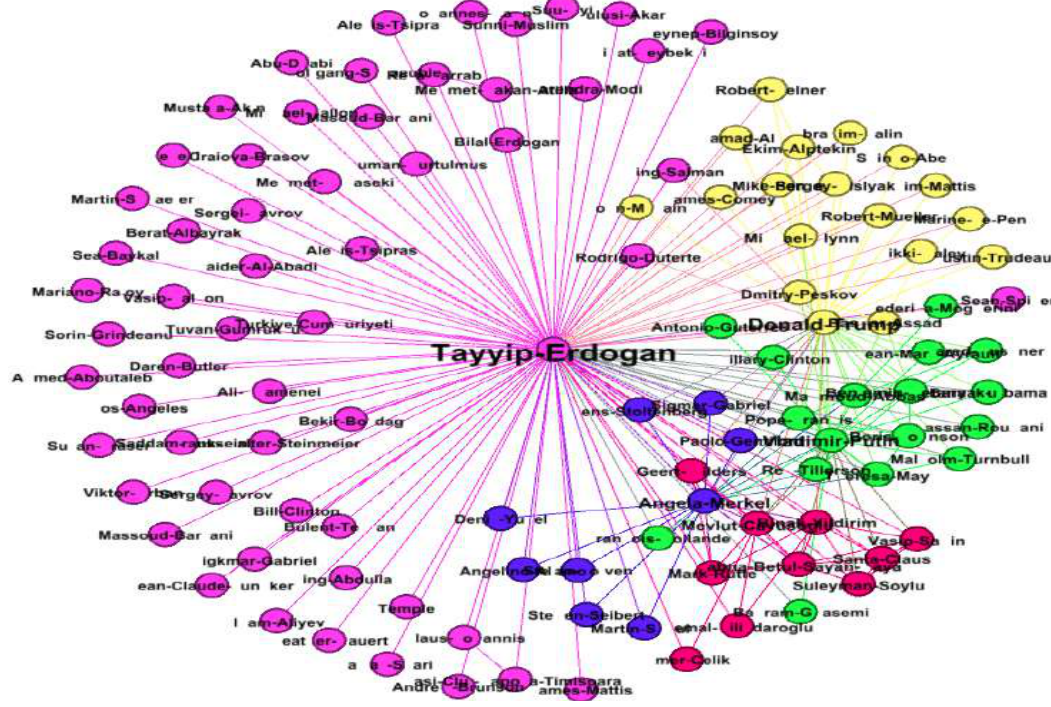
Figure 16: Modularity 2017 (Source: Authors ‟ depiction)